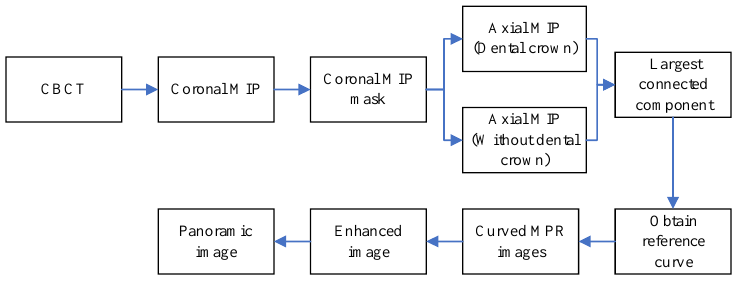
Figure 1. Workflow of the proposed method.